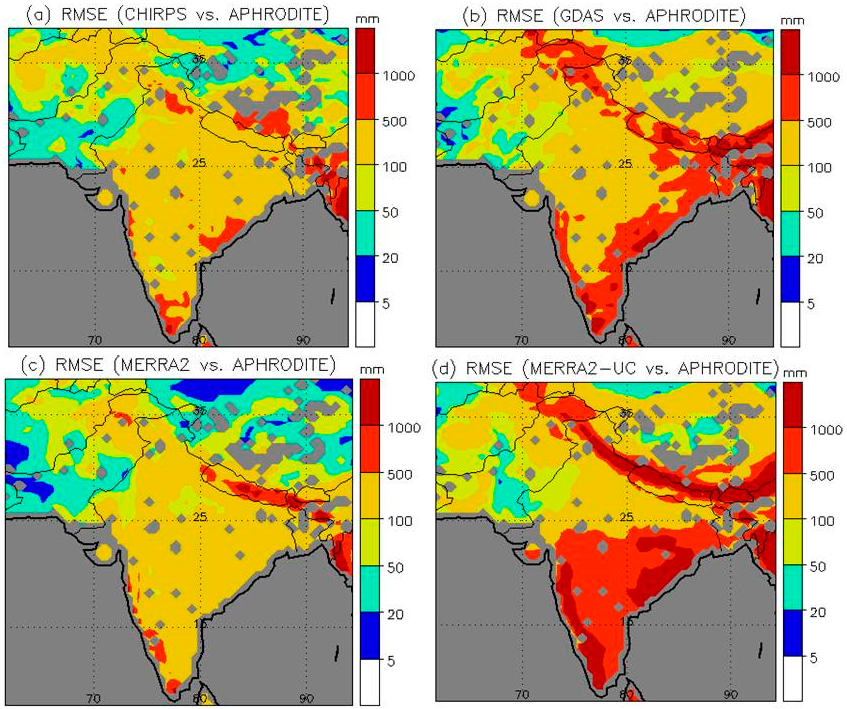
Figure 2. RMSE of annual precipitation based on the period from 2001 to 2007 between APHRODITE and ( a ) CHIRPS, ( b ) GDAS, ( c ) MERRA2-C, and ( d ) MERRA2-UC. The grey color indicates a region with no data.